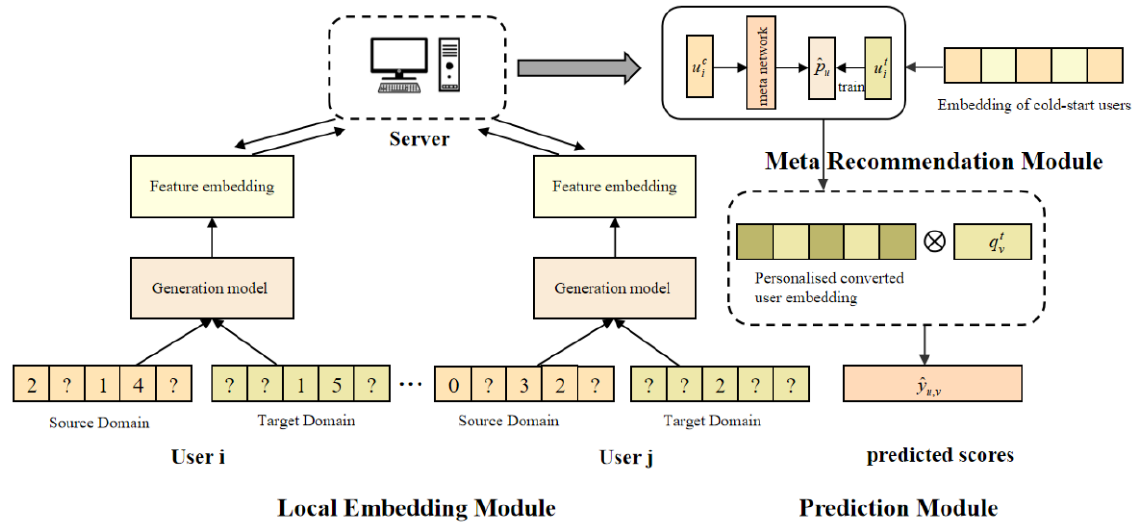
Figure 3. The framework of MFPCDR model.